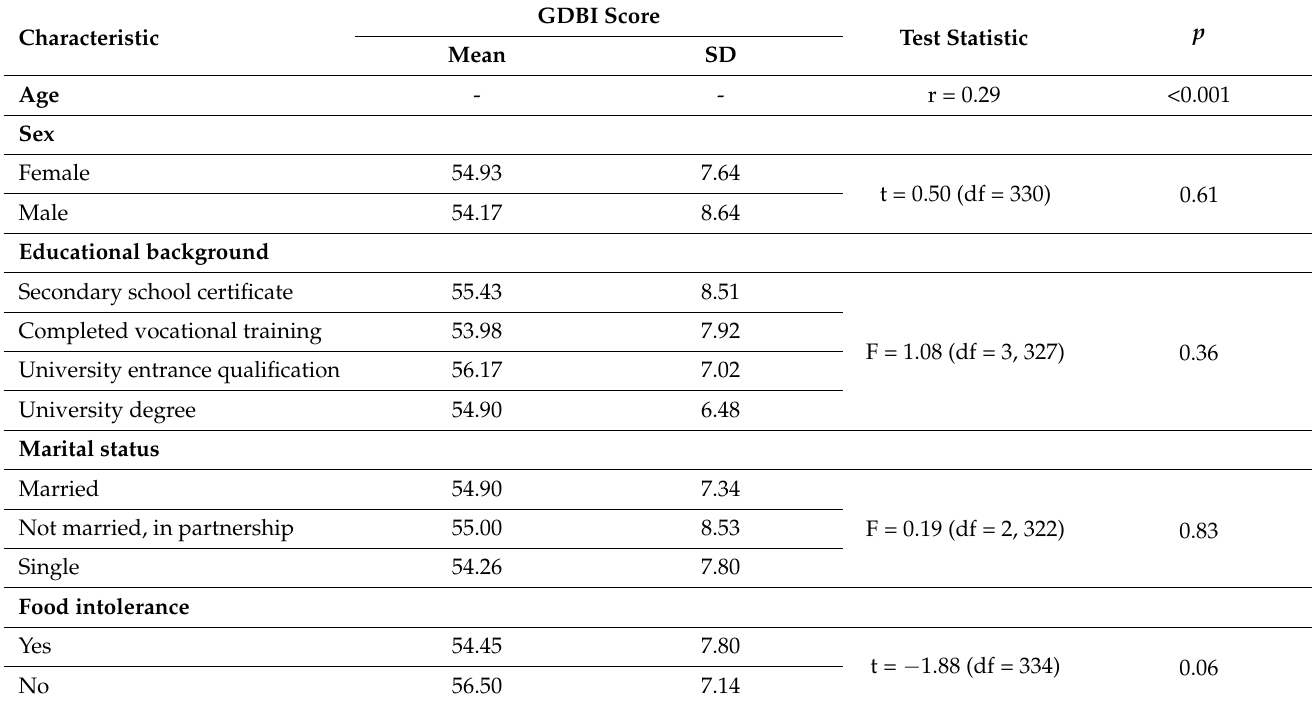
Table 3. Interrelations between the GDBI score and sociodemographic